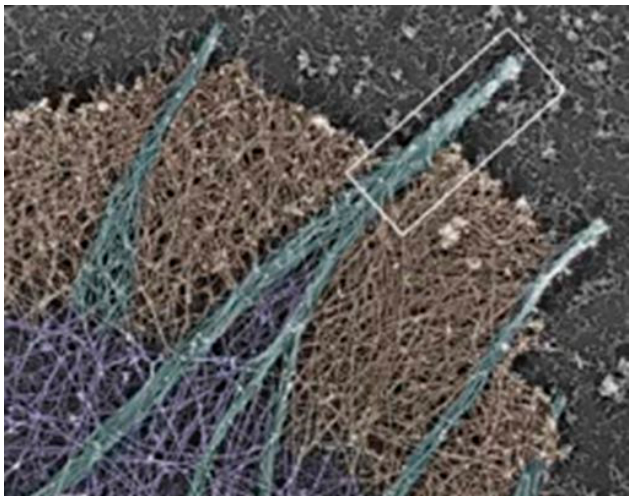
Figure 8. Electron micrograph of actin-based membranous protrusions from leading edges of cultured mouse melanoma cells as denoted by the white rectangle. [43].